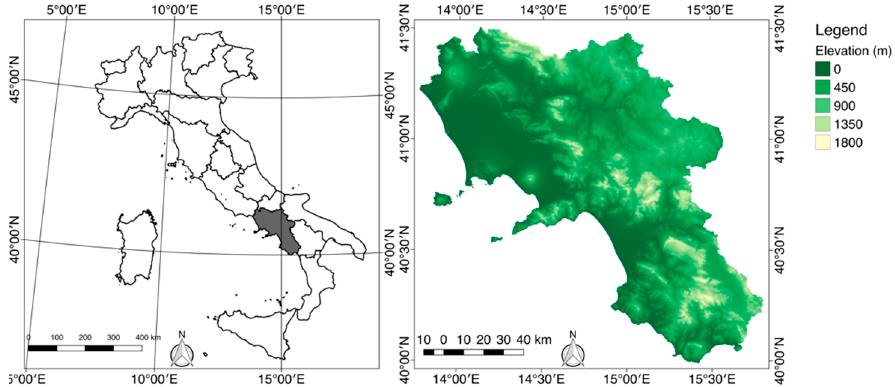
Figure 1. Study area is Campania region, Italy (40°83 ′ N, 14°13 ′ E, 13595 km 2 ).